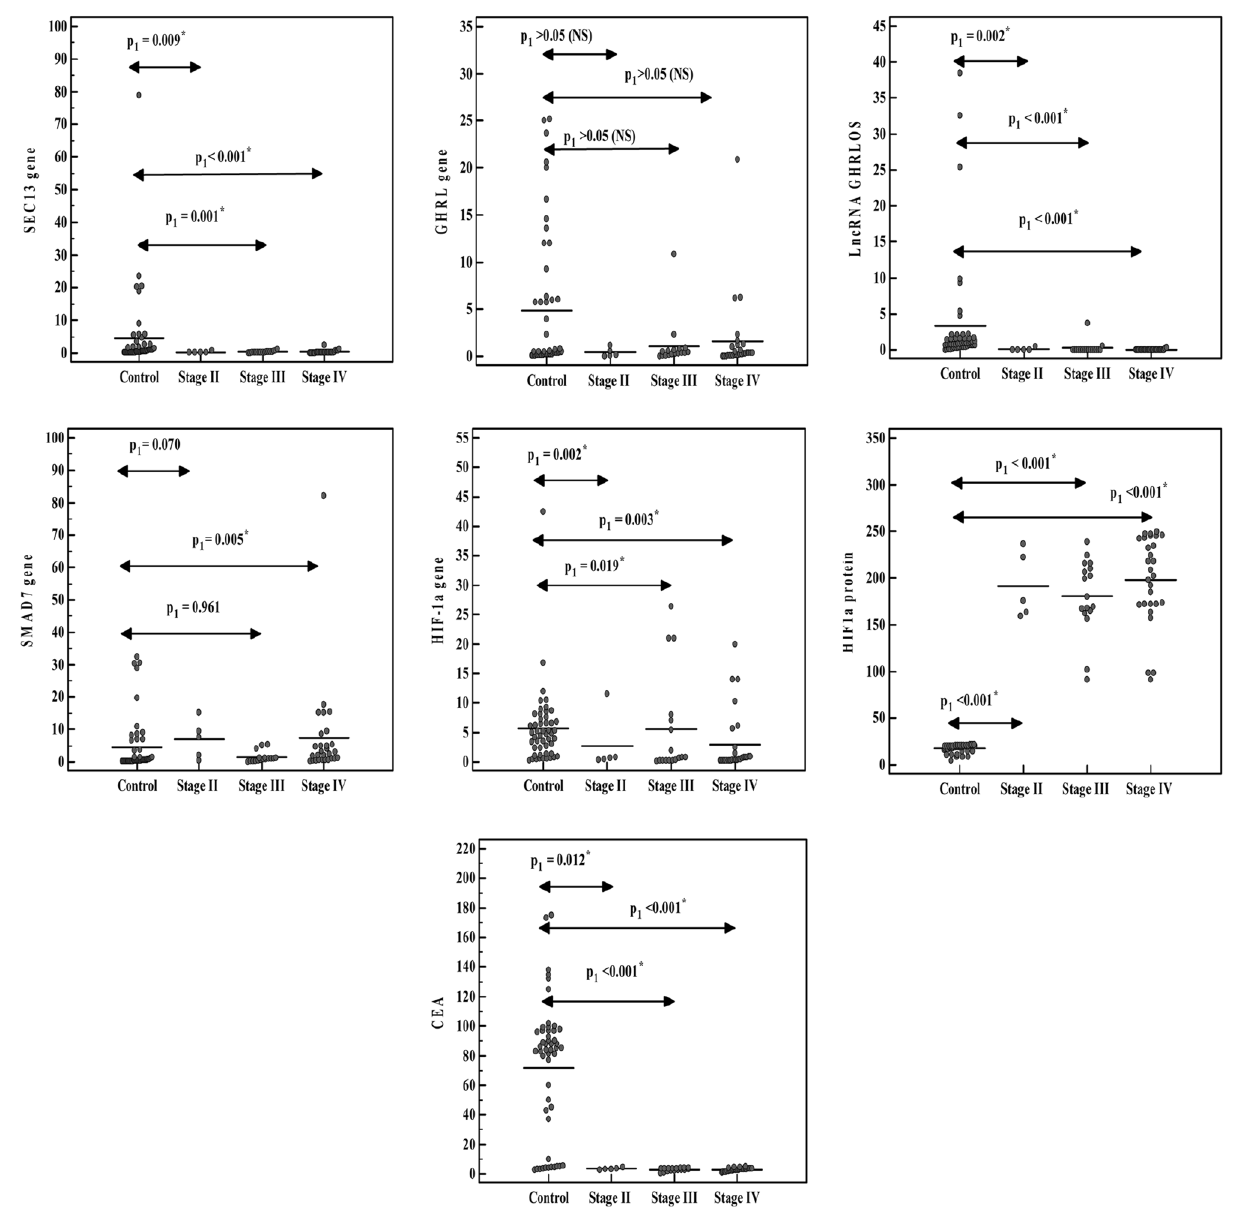
Figure 1. SEC13, GHRL, lncRNA GHRLOS, SMAD7, HIF-1α expression, serum HIF-1α (ng/ml) and CEA levels (ng/ml) in control and gastric cancer patient groups with different stage.